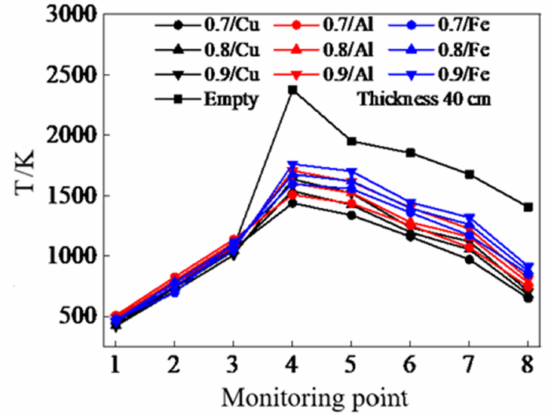
Figure 18. Maximum temperature at each monitoring